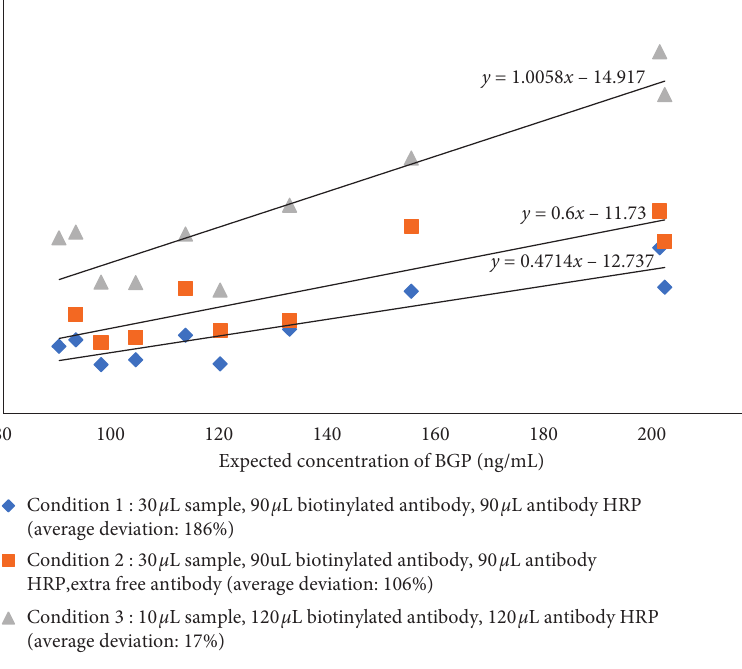
Figure 2: Optimisation of the reaction conditions.